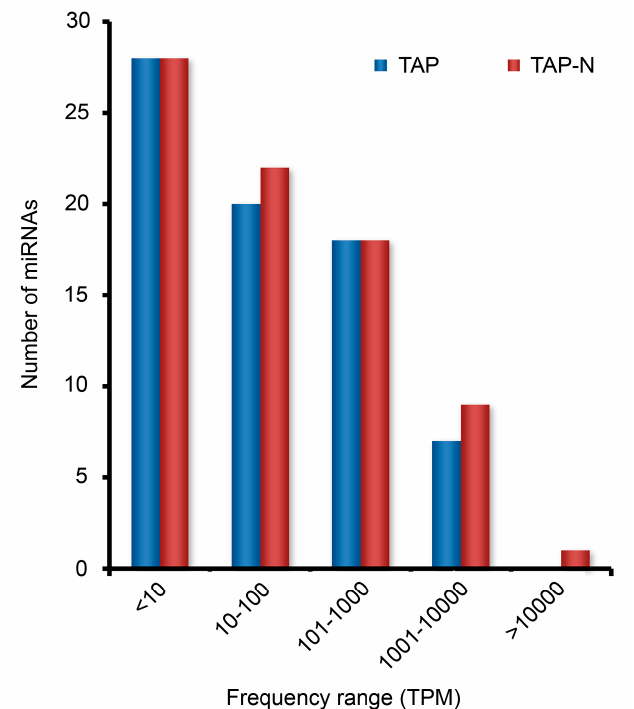
Figure 3. Frequency of read counts (TPM) for individual, known miRNAs presented in TAP and TAP-N libraries. The read count is based on the quantity of reads detected during the deep sequencing of the small RNA library for miRNAs detection was used the miRBase release 14.0. TAP represents read counts of individual, known miRNAs of C. reinhardtii cultivated in nitrogen-replete medium; TAP-N represents read counts of individual, known miRNAs of C. reinhardtii cultivated in nitrogen deficiency medium.